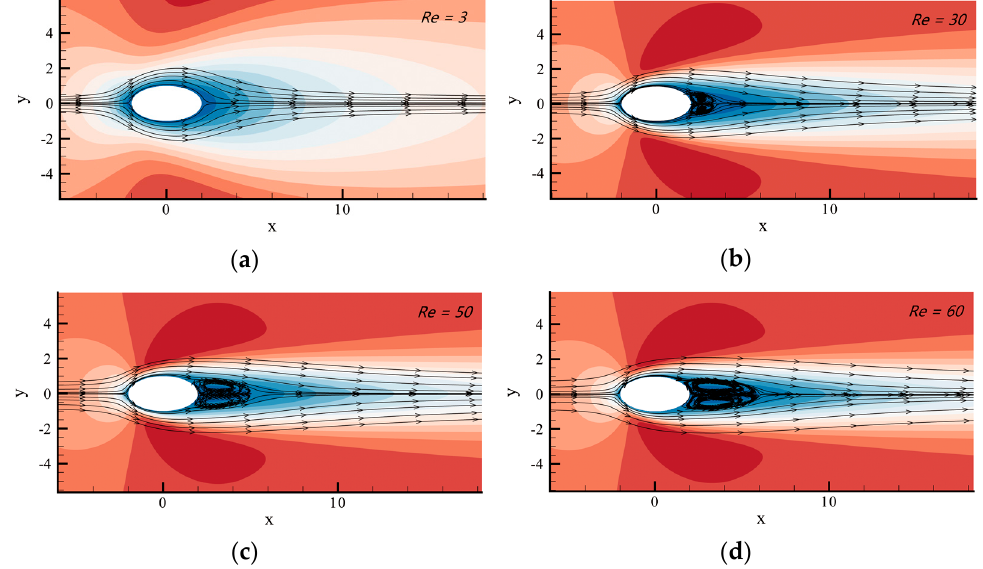
Figure 15. Steady flow line diagrams through elliptical cylinders at different Reynolds numbers. ( a – d ) correspond to the Reynolds number 3, 30, 50 and 60, respectively.